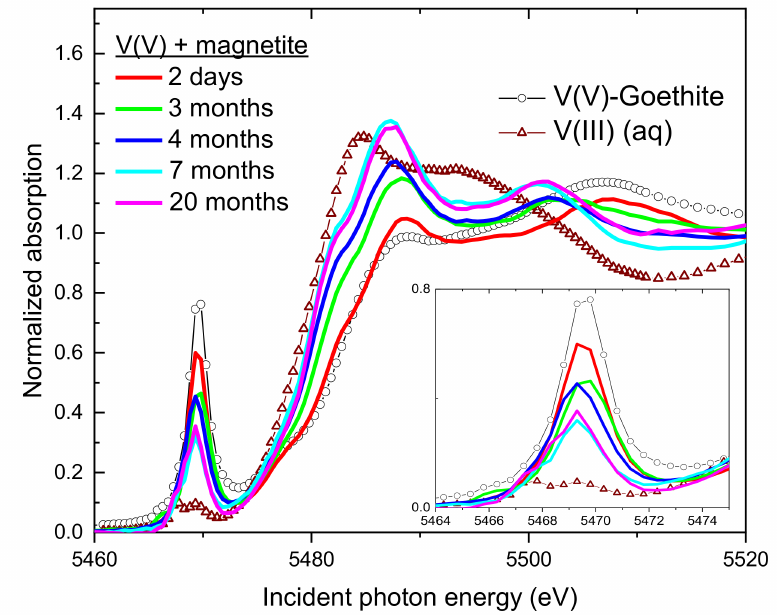
Figure 6. The V K-edge XANES spectra of the solids in the magnetite system over time compared to representative standards V(V) sorbed to goethite and aqueous V(III). Inset shows details in the pre-edge region.